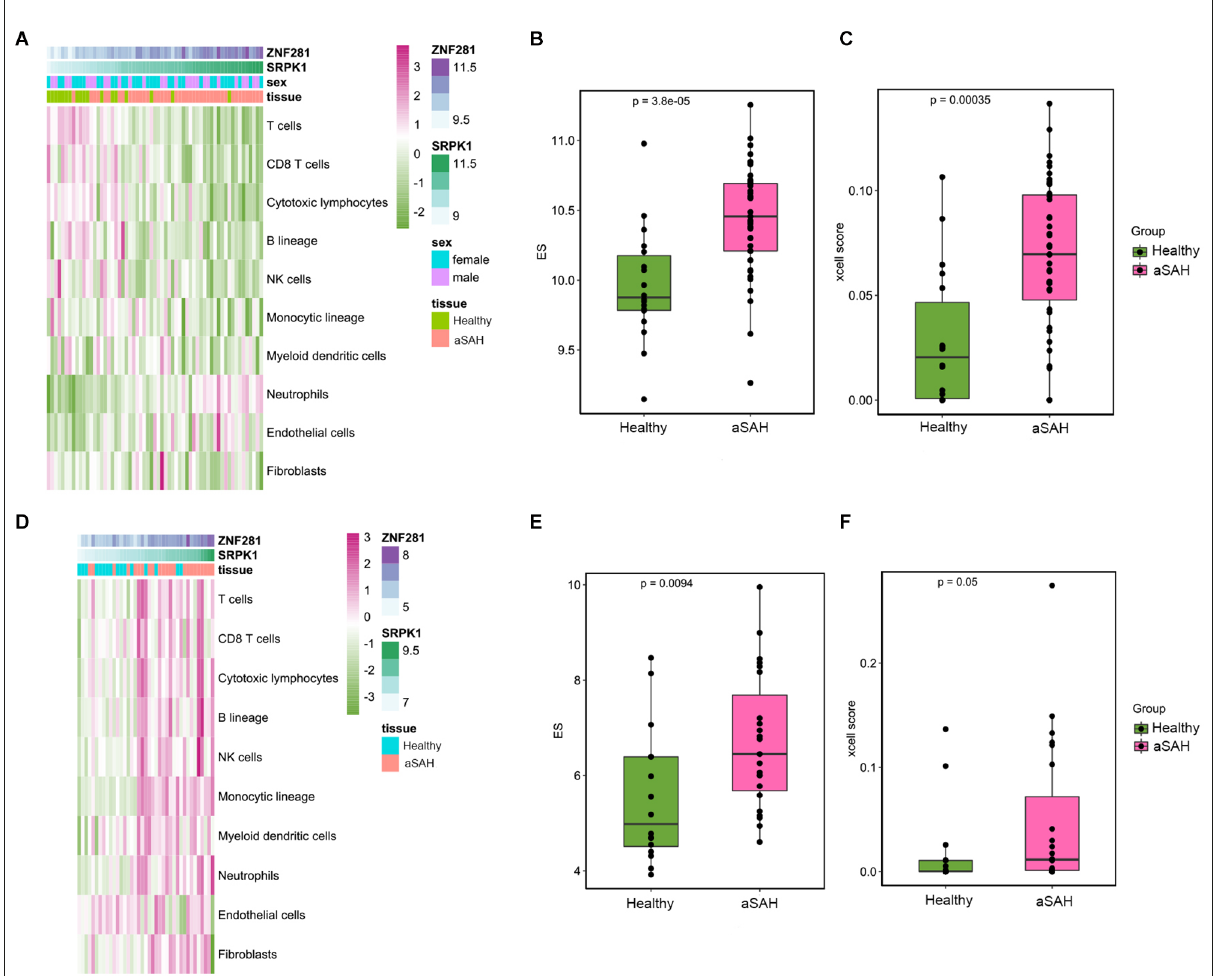
FIGURE10 Immune landscape in the tissue samples between aSAH and healthy samples analyzed by MCPcounter and xcell algorithm. (A) The heatmap showing the overall enrichment of 10 immune cells in the blood sample. (B) The boxplot showing the MCPcounter enrichment scores of neutrophils between aSAH and healthy groups. (C) The boxplot showing the xcell enrichment scores of neutrophils between aSAH and healthy groups. (D) The heatmap showing the MCPcounter results of the arterial sample dataset. (E,F) The boxplot showing the MCPcounter and xcell enrichment scores of neutrophils between aSAH and healthy groups in the arterial sample